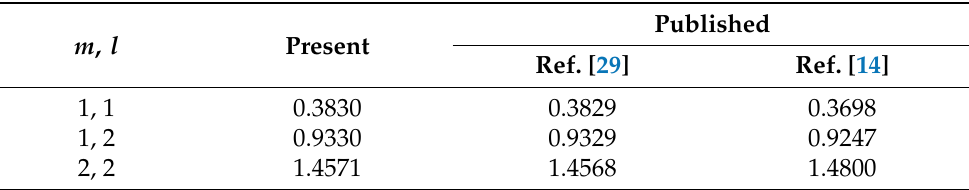
Table 5. Comparison of nondimensional frequency ( ¯ Ω = L ω tromagnetic plate ( L = W = 60 nm, h = 5 nm, J 1 = J 2 = V 0 = P 0 = 0).